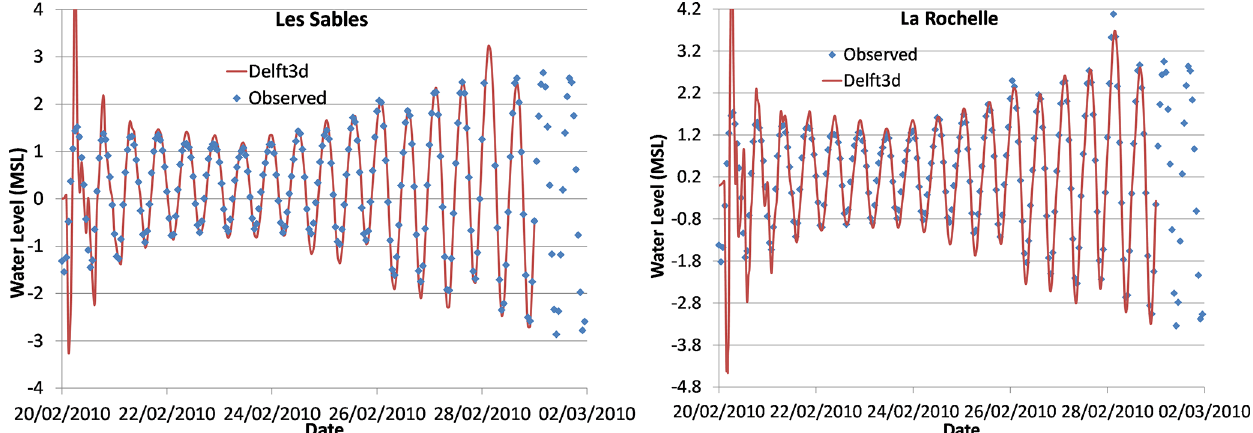
Figure 4. Observed and modelled tide at La Rochelle and Les Sables-d’Olonne. Note that during the peak of the storm tide at Les Sables- d’Olonne, the tide measuring gauge was out of operation, resulting in a missing data point in that data series.